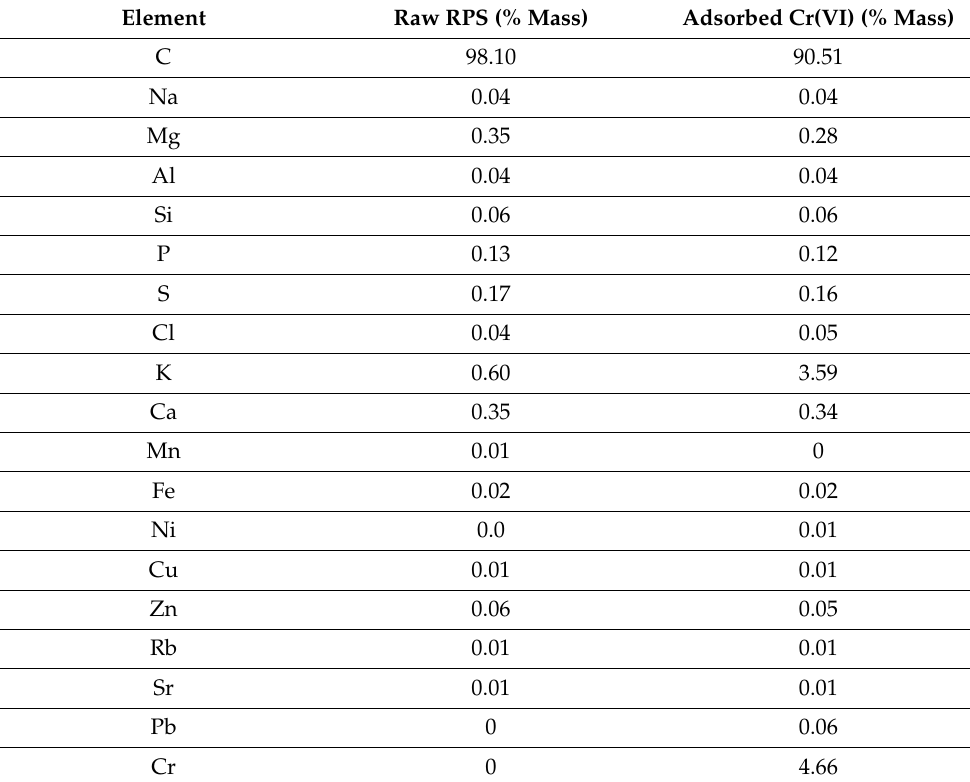
Table 1. Chemical composition of RPS biomass before and after Cr(VI) adsorption. Element Raw RPS (%